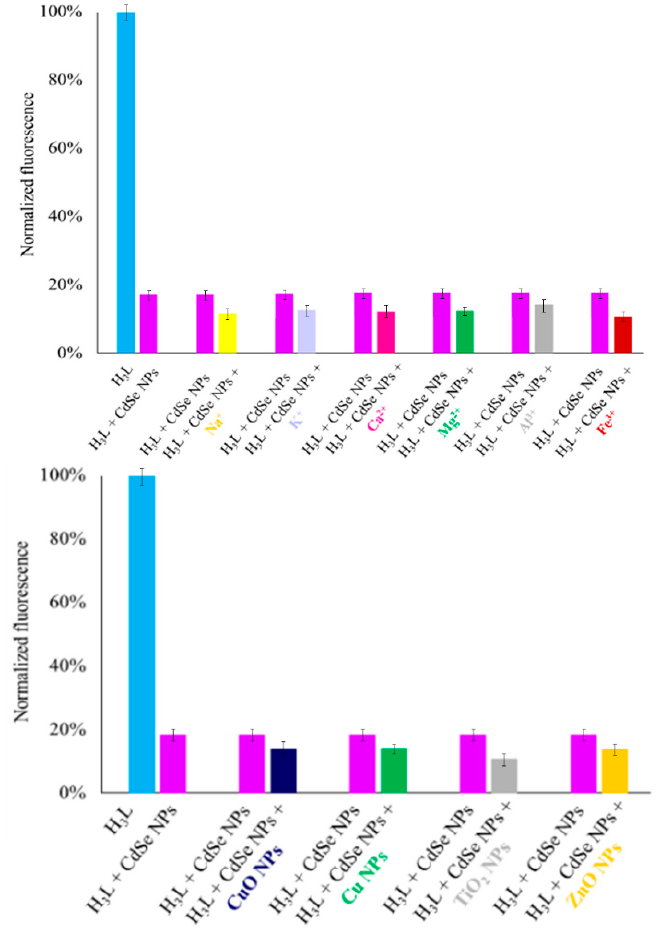
Figure 6. Fluorescence responses of H 3 L (2.5 nM, 1.26 ppb) toward CdSe NPs (8 ppm) in the presence of various NPs ( bottom ) such as Cu NPs (8 ppm), CuO NPs (4 ppm), TiO 2 NPs (4 ppm), and ZnO NPs (4 ppm) and some common metal ions ( top ) such as Na + (8 ppm), K + (8 ppm), Fe 3+ (8 ppm), Mg 2+ (2 ppm), Ca 2+ (2 ppm), and Al 3+ (2 ppm). All experiments were performed in 4 mL of an ethanol–water solution in 80:20 v / v (pH 11) under λ exc = 400 nm.